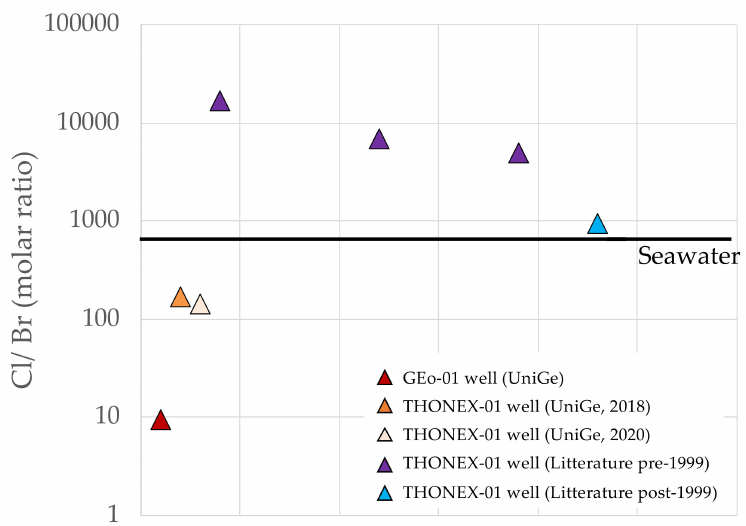
Figure 10. Cl/Br molar ratios for the GEo-01 and Thonex